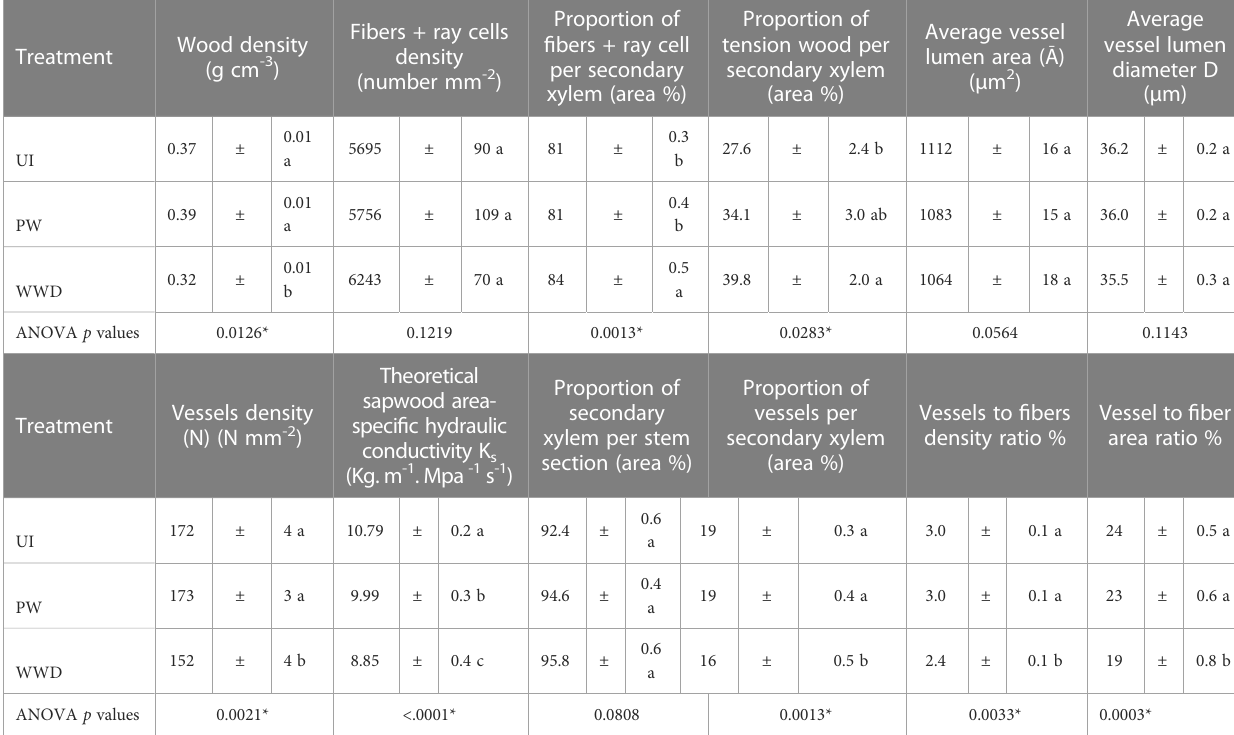
TABLE 2 Xylem parameters and the vessels feature of Salix miyabeana SX67 plants under different irrigation treatments. Treatment